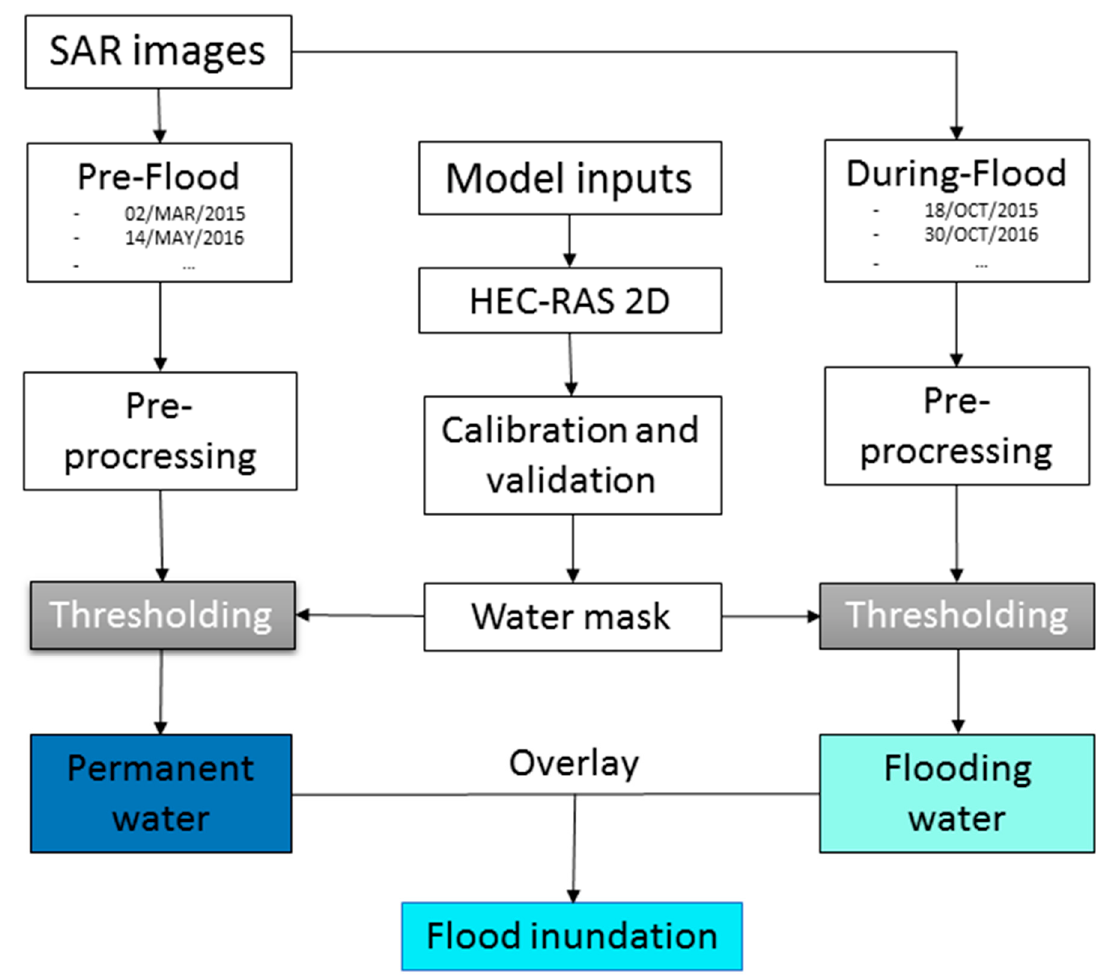
Figure 2. Flowchart of the methodology. SAR stands for Synthetic Aperture Radar and HEC-RAS 2D is two dimentional Hydrologic Engineering Centers River Analysis System model.